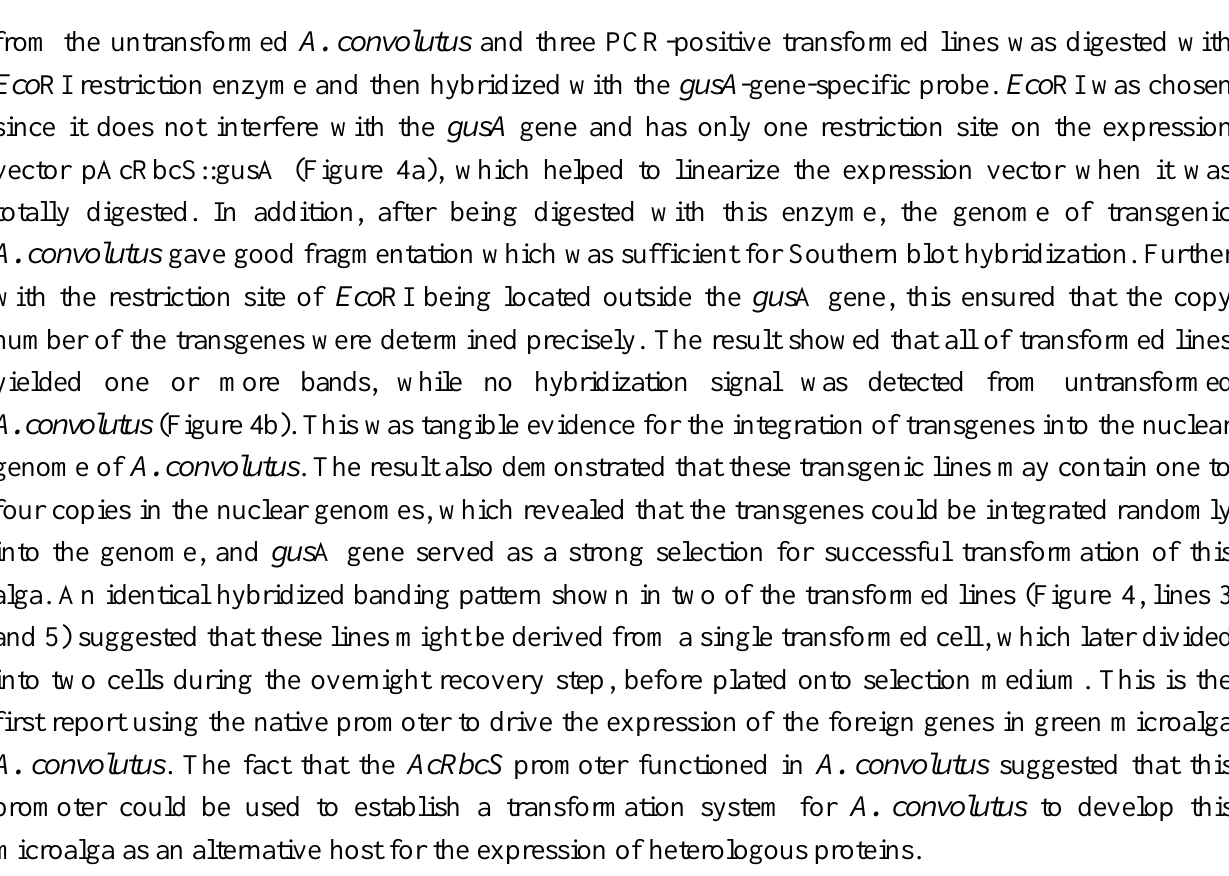
Figure 4. Southern hybridization analysis of transformed A. convolutus . ( a ) The presentation of the T-DNA region with AcRbcS promoter fused with gusA and hpt genes. The position of Eco RI restriction site was indicated; ( b ) Genomic DNA (15 µg) from three PCR-positive transformed lines (lines 2, 3 and 5) and untransformed cell was digested with Eco RI restriction enzyme and probed with a biotin-labeled gusA gene-specific probe.